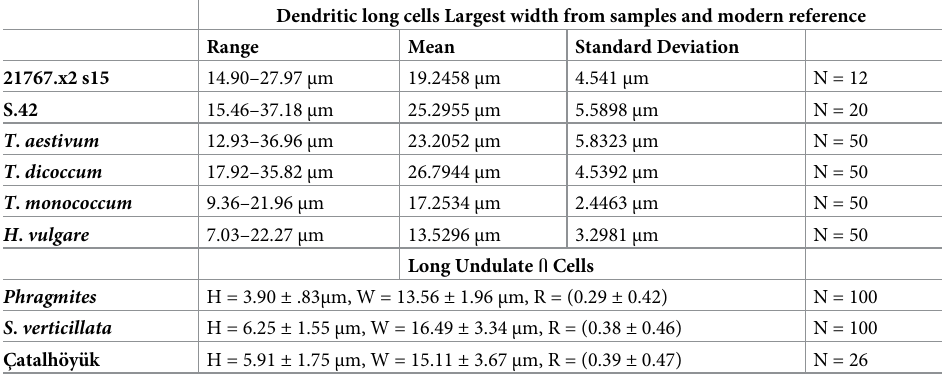
N refers to the number of measurements, R refers to the ratio between H/W. Comparison between modern references and archaeological